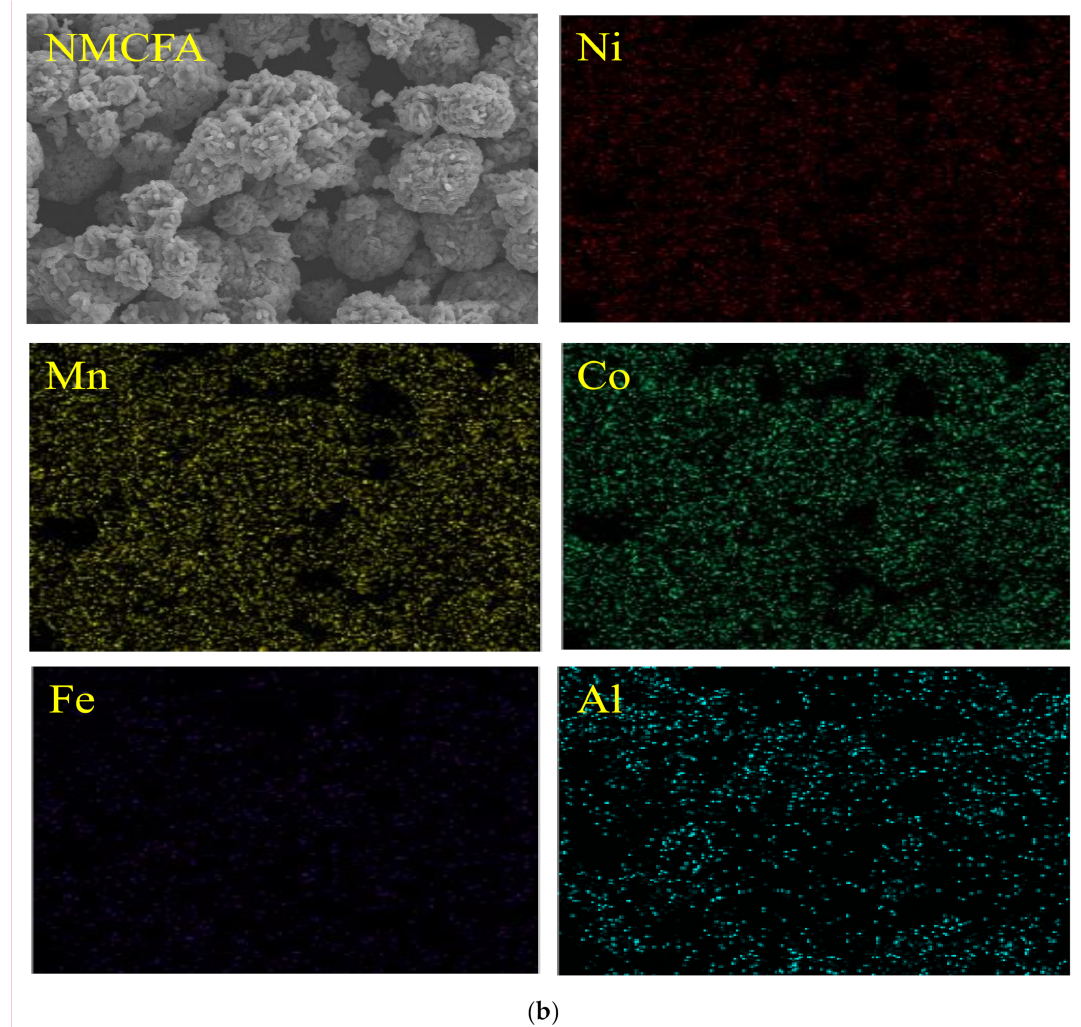
Figure 2. Elemental distribution of the cathode active materials analyzed by EDS: ( a ) NMC and ( b )